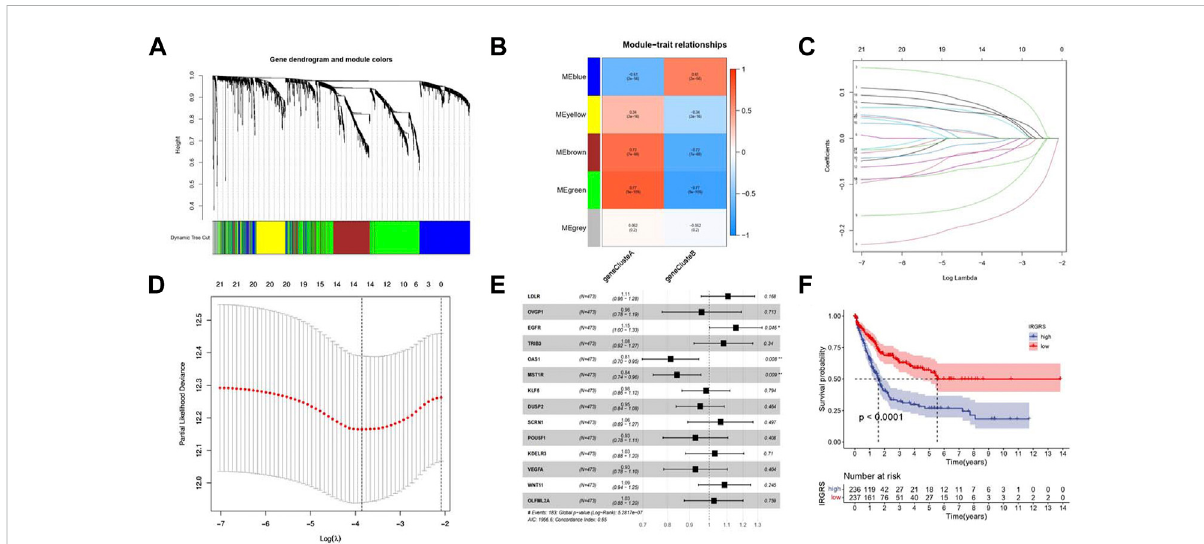
FIGURE 3 Methods abouthowto fi lterthehubgenesto construct IRGRSsystem. (A) .Clusteringdendrogramsshows therelationshiopbetweengeneand its corresponding module. (B) . Heatmap by WGCNA suggests Module-trait associations. Each row corresponds to a ME and column corresponds to genecluster. The number in the rectangle is the correlation coef fi cient, and the number in brackets is the corresponding p value. (C) . Least absolute shrinkage and selection operator (LASSO) coef fi cient pro fi les of 21 genes. (D) . Partial likelihood deviance for LASSO coef fi cient pro fi les. The verticaldottedlineisshownattheoptimalvalues,Thereddotsrepresentthepartiallikelihoodvalues,thegraylinesrepresentthestandarderror(SE). (E) . Forest plots of the multivariate Cox hazard model for overall survival. * p < 0.05, ** p < 0.01, *** p < 0.001, **** p < 0.0001. Unadjusted HRs are shown with 95% con fi dence intervals. (F) . Survival analyses for high and low IRGRS patient groups in training cohort using Kaplan-Meier curves ( p < 0.0001, Log-rank